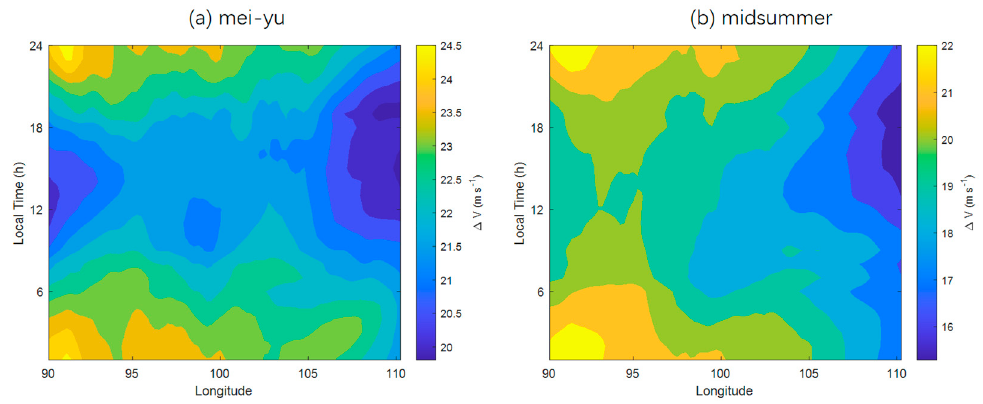
∆ V during the ( a ) mei-yu and ( b ) midsummer Figure 11. Diurnal variation in ∆V during the ( a ) mei-yu and ( b ) midsummer periods. Figure 11. Diurnal variation in